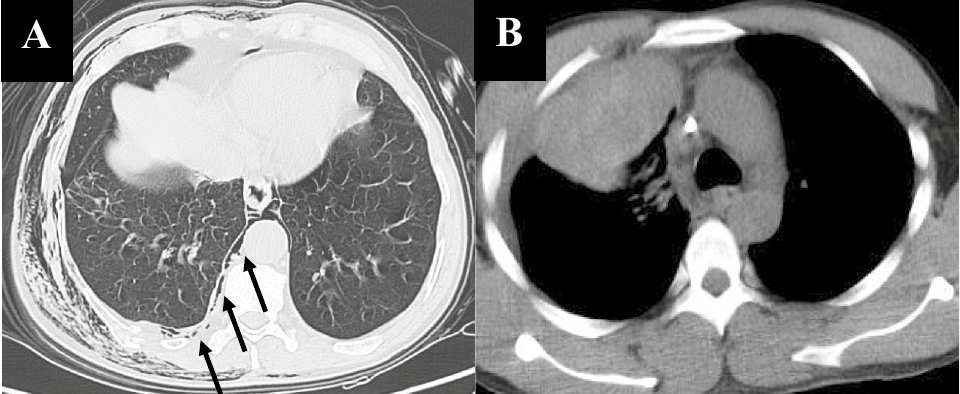
Fig. 3 Abnormal attenuation of the EPS. A 41‑year‑old male patient presented with poly‑trauma secondary to road traffic accident. Axial CT mediastinal window image showing rib fracture, surgical emphysema, and right lower lobe EPS air (very fine weblike internal septations characteristic of extra‑pleural air) (arrows). B 39‑year‑old male patient presented with sudden dyspnea and shortness of breath after central venous insertion, i.e., iatrogenic (convexity of extra‑pleural hematoma